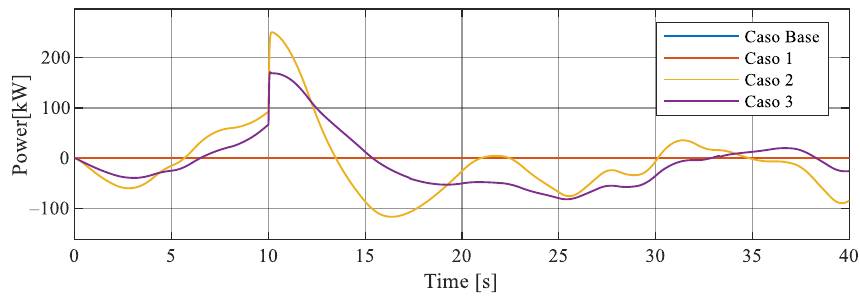
Figure 20. Active power injected by the BESS in the variable wind speed scenario.